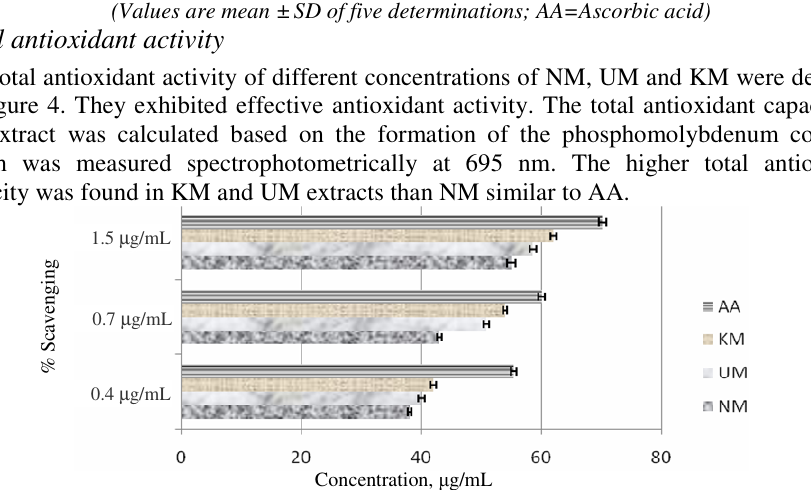
Figure 4. Total antioxidant activity of ethanol extract of NM , UM and KM (Values are mean ± SD of five